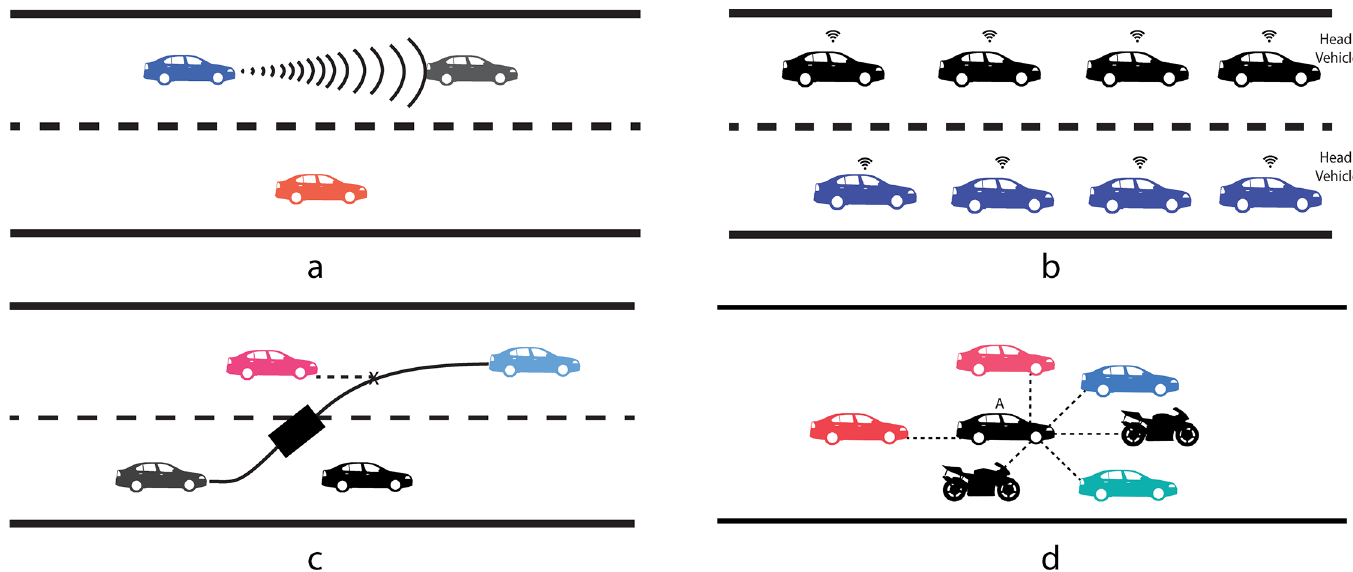
Fig 1. Collision avoidance scenarios addressed extensively in literature. (a) Rear end collisionavoidance, (b) Cooperative collisionavoidance in Adaptive Cruise Controlor Platooning, (c) Lane departureor Lateral collisionavoidance, (d) Flock like topology(A typical scenarioin congestedurban road).